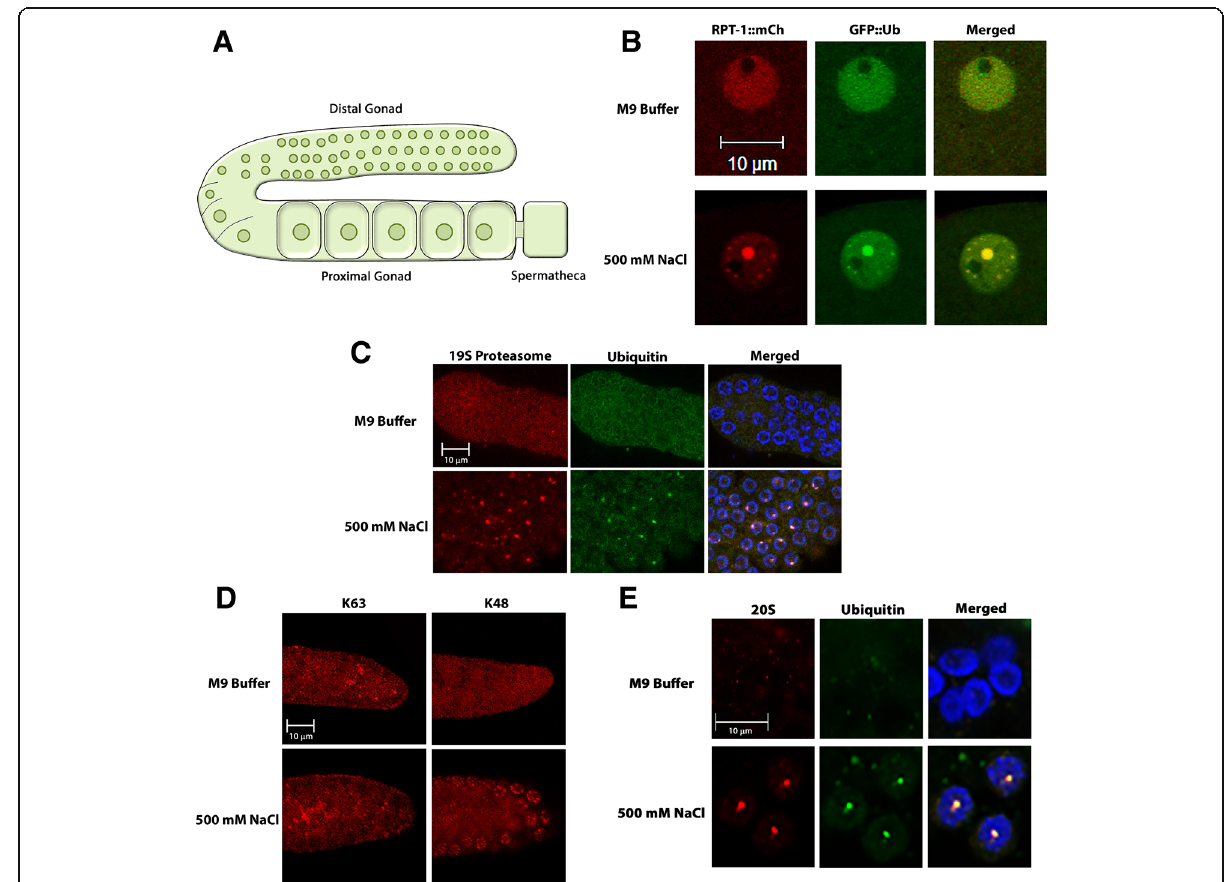
Fig. 1 Salt stress induces redistribution of ubiquitin and proteasome into nuclear stress bodies. a Reproductive tissue of C. elegans. The C. elegans gonad is a U-shaped organ with mitotically dividing cells at the distal tip. The distal region of the gonad is syncytial and oocytes become increasingly cellularized and larger as they progress through the proximal region towards the spermatheca. b Live imaging of GFP::Ub ( green ) and RPT-1::mCh ( red ) in proximal oocytes. During unstressed (M9 buffer) conditions ubiquitin and 19S proteasome were present in both nucleus and cytoplasm, but appeared to be more concentrated in the nucleus. The merged image shows ubiquitin, proteasome and DAPI channels. In stressed (500 mM NaCl) conditions ubiquitin and RPT-1 concentrate in stress bodies in the nucleus. A single oocyte is shown in each row. SINGs were found in salt stress (66/ 80 oocytes), but were absent in unstressed conditions (0/80) oocytes). Data were collected from 2 independent experiments ( n =20 worms). Scale bar indicates 10 μ m. c Antibody staining of ubiquitin and 19S proteasome in the distal gonad. Gonads of unstressed and stressed young adult C. elegans were dissected out and stained with an ubiquitin antibody ( green ) and a 19S proteasome antibody ( red ). The merged image shows the ubiquitin, proteasome, and DAPI channels. Both ubiquitin and proteasome where found to be diffuse within the nucleus in unstressed conditions (0/600 oocytes with SINGs), but localized into SINGs during salt stress (468/600 oocytes). Data were collected from 3 independent experiments ( n =30 worms). Scale bar indicates 10 μ m. d K63 and K48 polyubiquitin antibody staining in the distal gonad. During exposure to 500 mM NaCl K48 chains localized into SINGs (552/600 oocytes), whereas, K63 chains show no localization to SINGs in response to stress (0/600 oocytes). Data were collected from 3 independent experiments ( n = 30 worms). Scale bar indicates 10 μ m. e 20S proteasome subunit antibody staining. An antibody to the alpha 1 subunit of the 20S proteasome ( green ) was used to stain stressed (500 mM NaCl) and unstressed (M9) gonads. A region of the distal gonad is shown for each. The merged image shows the ubiquitin, proteasome, and DAPI channels. In unstressed conditions, SINGs containing 20S proteasome do not form (10/200 oocytes). Under stressed conditions the 20S proteasome subunit colocalizes with K48 ubiquitin chains ( red ) in SINGs (153/200 oocytes). Data were collected from 3 independent experiments ( n =30 worms). Scale bar indicates 10 μ